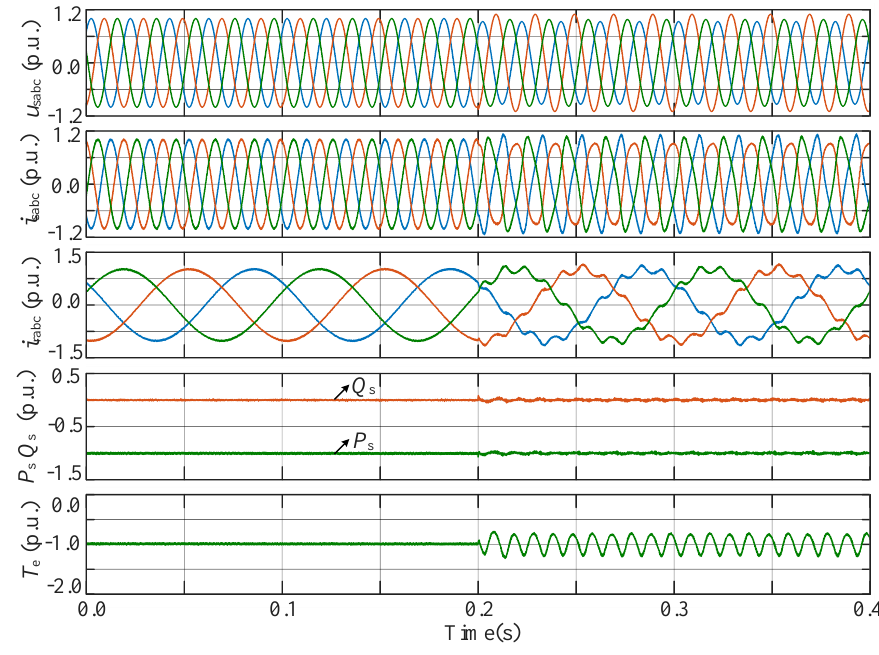
Figure 5. Simulation results during a 10% transient voltage unbalance.